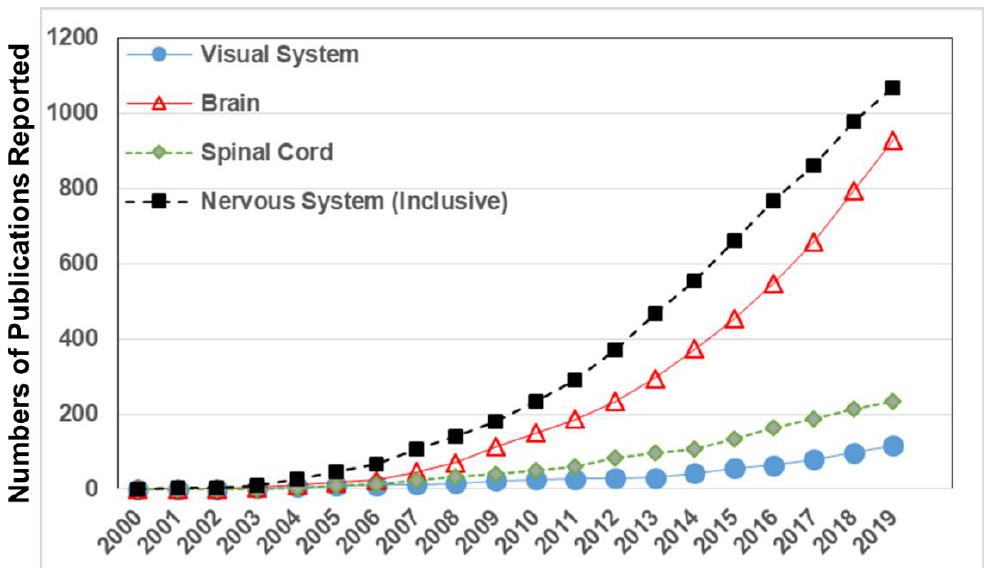
Figure 1. Numbers of published biomedical studies that applied microfluidic technologies to examine the nervous system (inclusive), brain (excluding visual system), spinal cord, and visual system. Data is gathered from publications reported in the Web of Science and National Library of Medicine (PubMed) each year from 2000 to date.